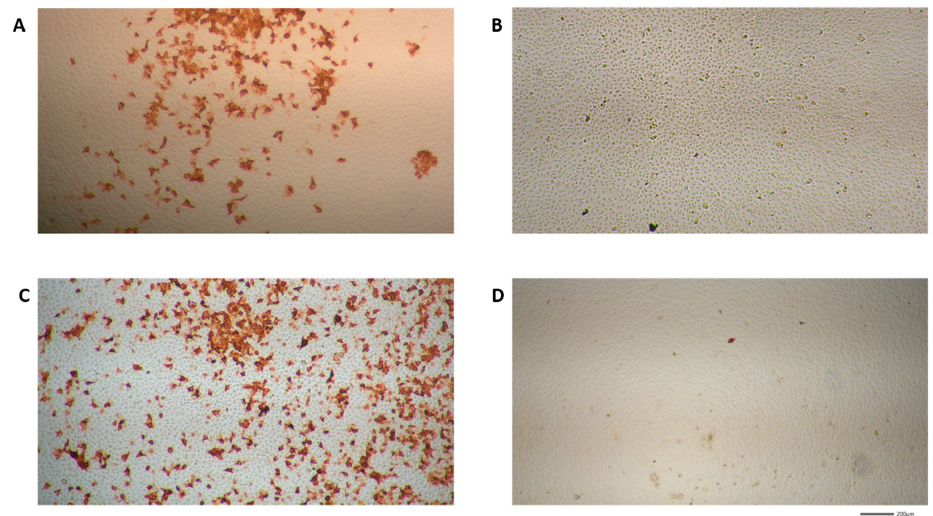
Figure 5. SARS-CoV-2 specific immunohistochemical staining (IHC) of VeroE6 cells treated with